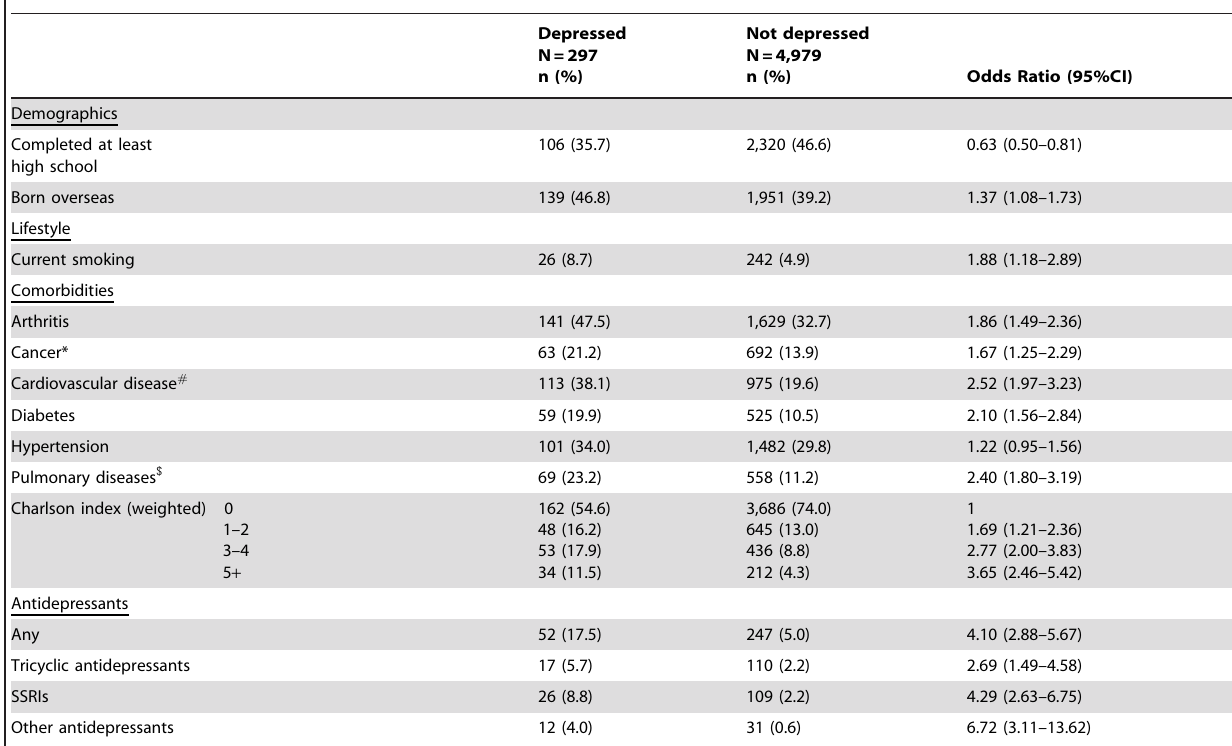
Table 1. Demographic, lifestyle and clinical factors associated with prevalent